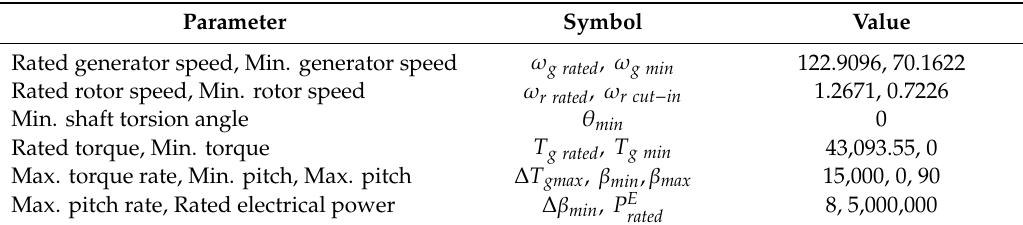
Table A2. The values of the bounds in the 5-MW VSWT